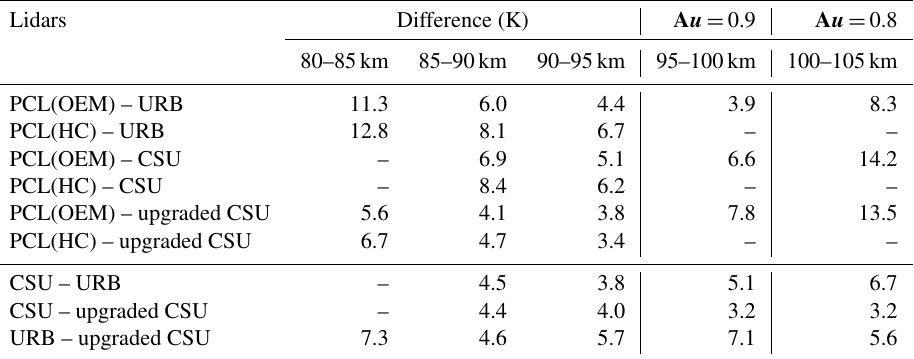
Table 4. Absolute value of the average PCL temperature differences with sodium lidars and the temperature difference between sodium lidars. The HC method does not provide the temperature above 95km; therefore, the columns with an altitude range greater than 95km are shown as